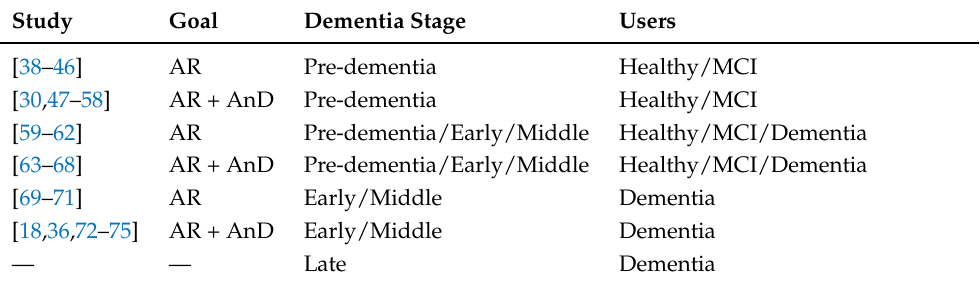
Table 1. Summary of methods of AR for